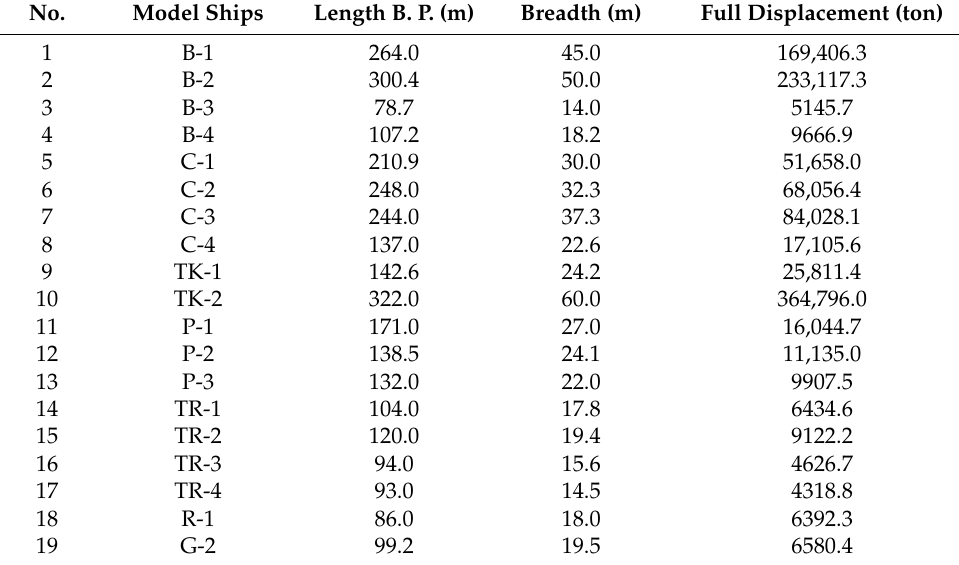
Table 1. Particulars of model ships.